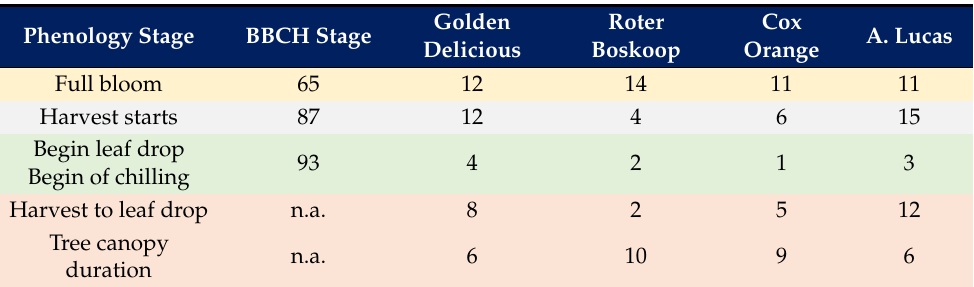
Table 4. Advancement of phenological stages (comparison phase II with phase I) and vegetation period in days based on 60 years of records at Klein-Altendorf